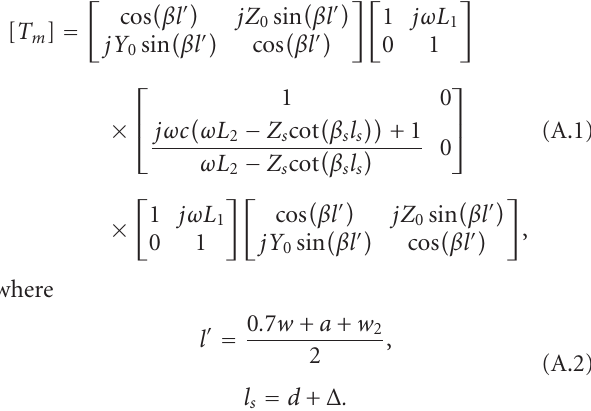
Figure 11: Schematic diagram and equivalent circuit of a T- junction with two bends.